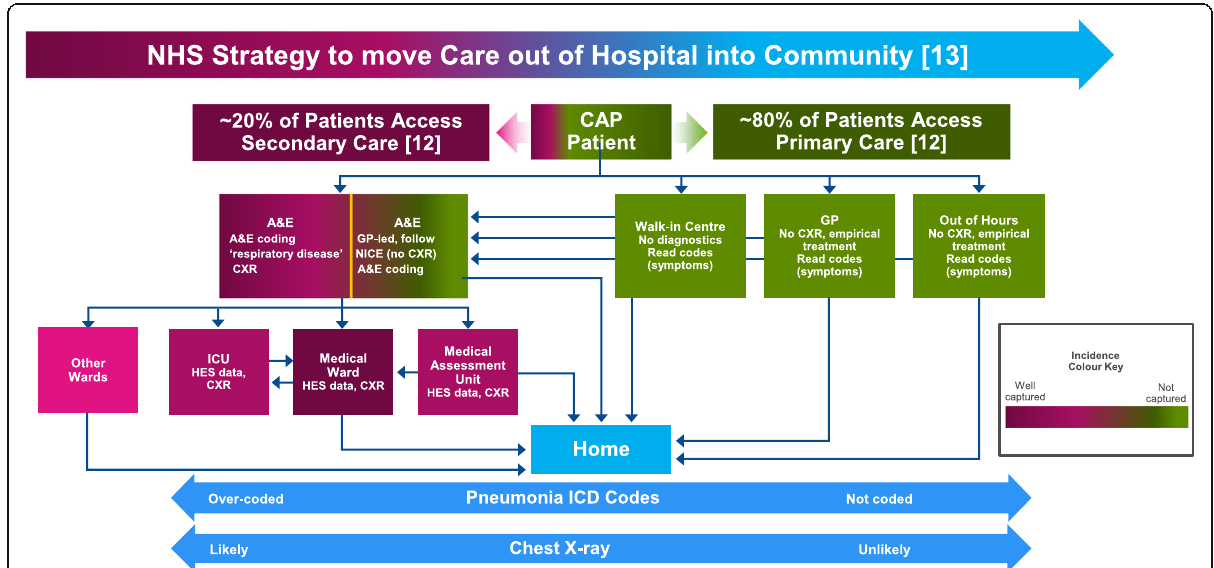
Fig. 2 Simplified schematic of the UK care pathway for adult patients with CAP accessing healthcare, and estimated capture of incidence rates. A&E, accident and emergency; CAP, community-acquired pneumonia; CXR, chest X-ray; GP, general practitioner; HES, hospital episode statistics; ICU, intensive care unit; NICE, National Institute for Health and Care